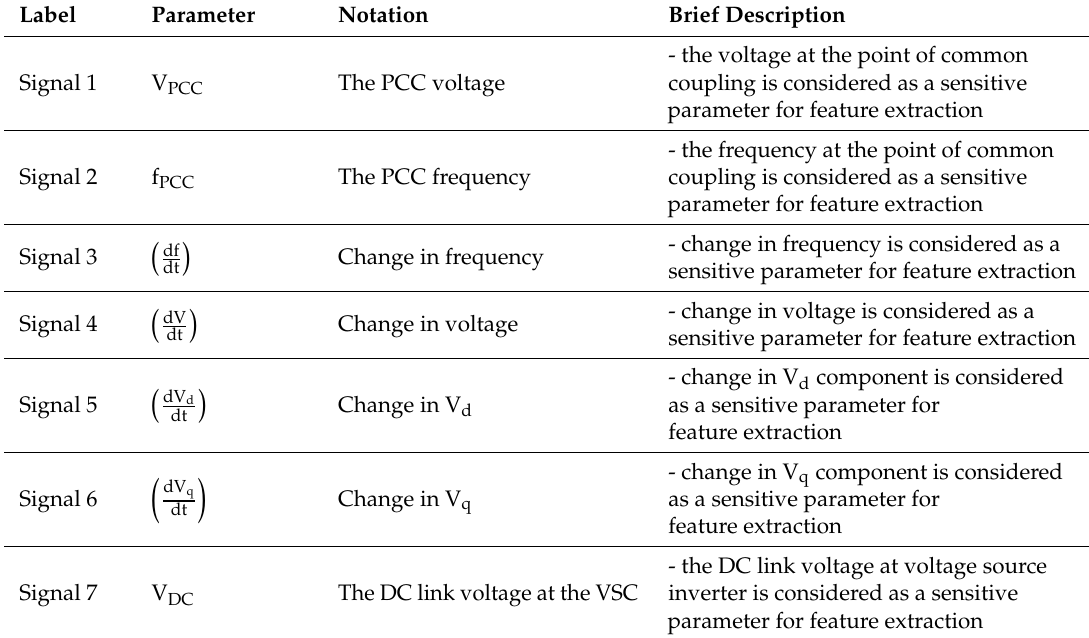
Table 3. The selected signals for feature extraction [36].